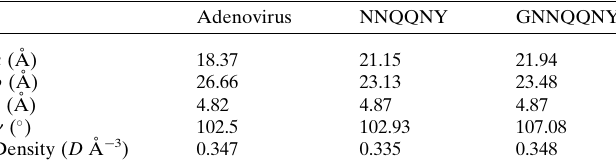
Table 1 Cell constants of the adenovirus octapeptide and two other crystal structures (Nelson et al. , 2005).